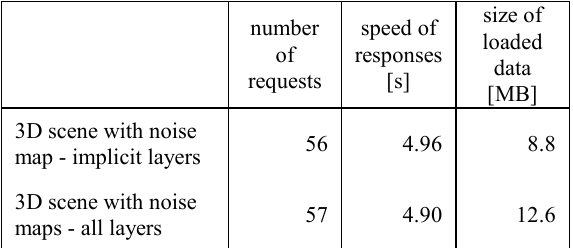
Table 3. Testing the loading speed of individual 3D